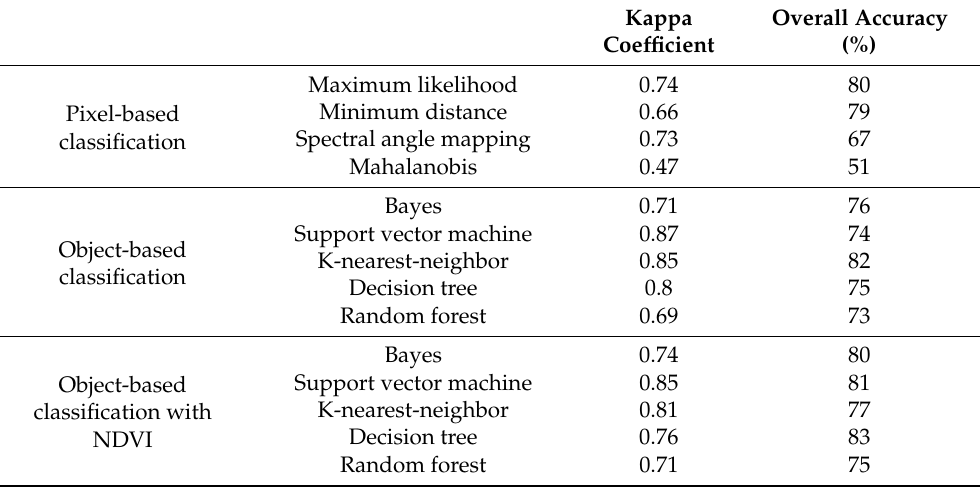
Table 4. Accuracy of classification of Sentinel-2 images using pixel-based methods, object-based methods and object-based methods with normalized difference vegetation index